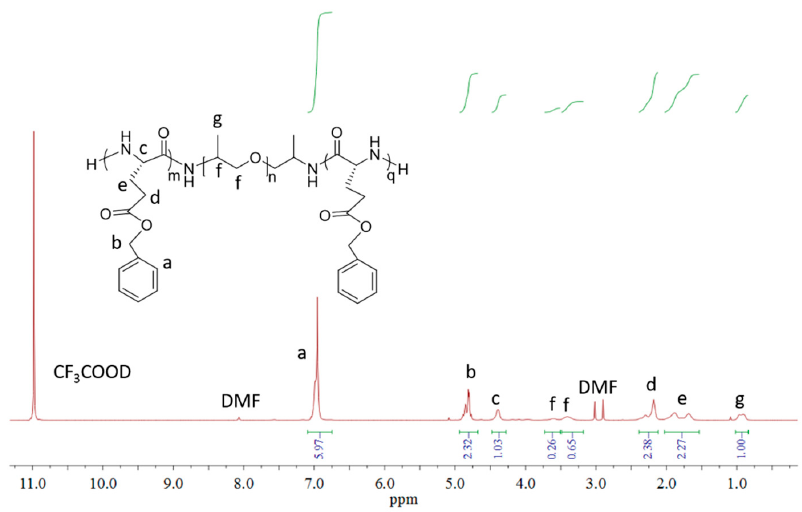
Figure 2. 1 H NMR spectrum of PBLG-PPG-PBLG in trifluoroacetic acid (CF 3 COOD).